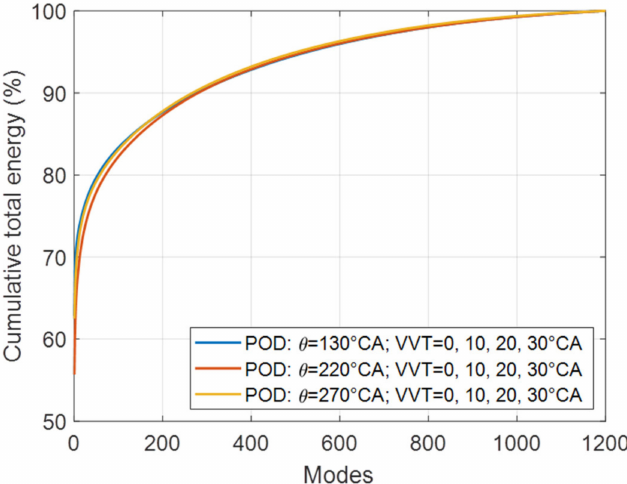
Figure 6. Cumulative kinetic energy by